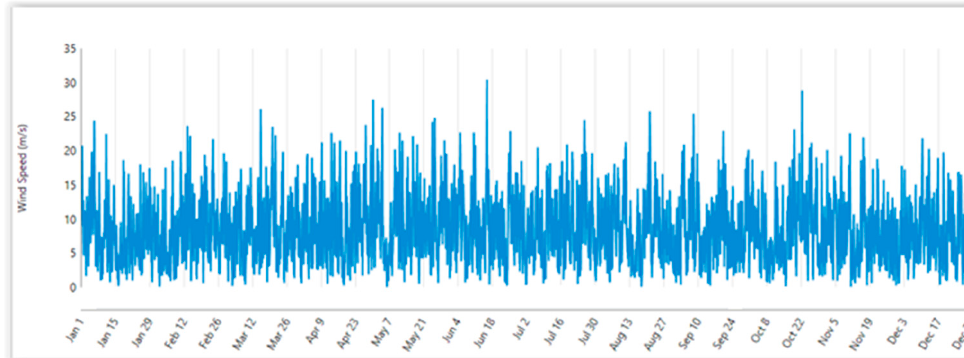
Figure 6. Annual wind speed for Foveaux site.